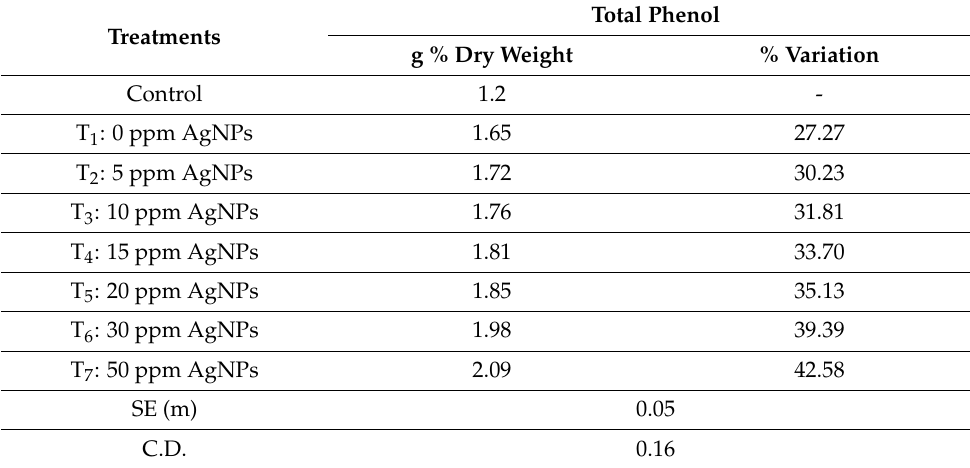
Table 3. Estimation of total phenol in spot blotch infected wheat plant leaves in response to nanopar- ticle